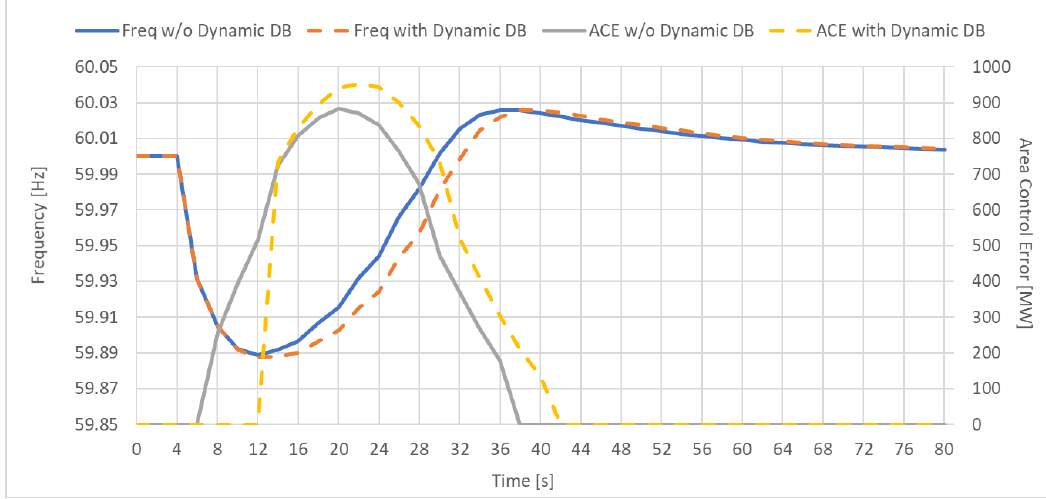
Figure 11. AGC frequency control with and without dynamic deadband.